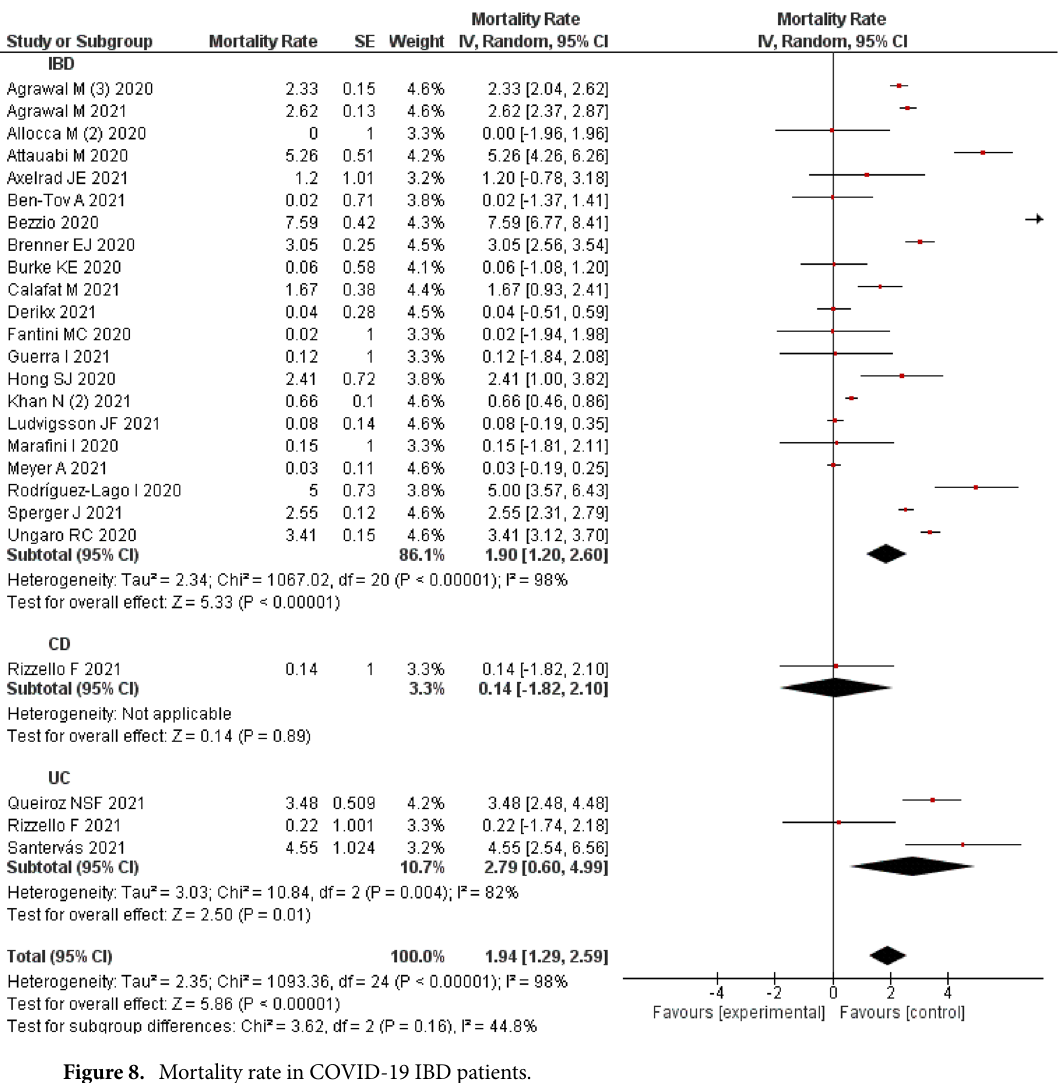
Figure 8. Mortality rate in COVID-19 IBD